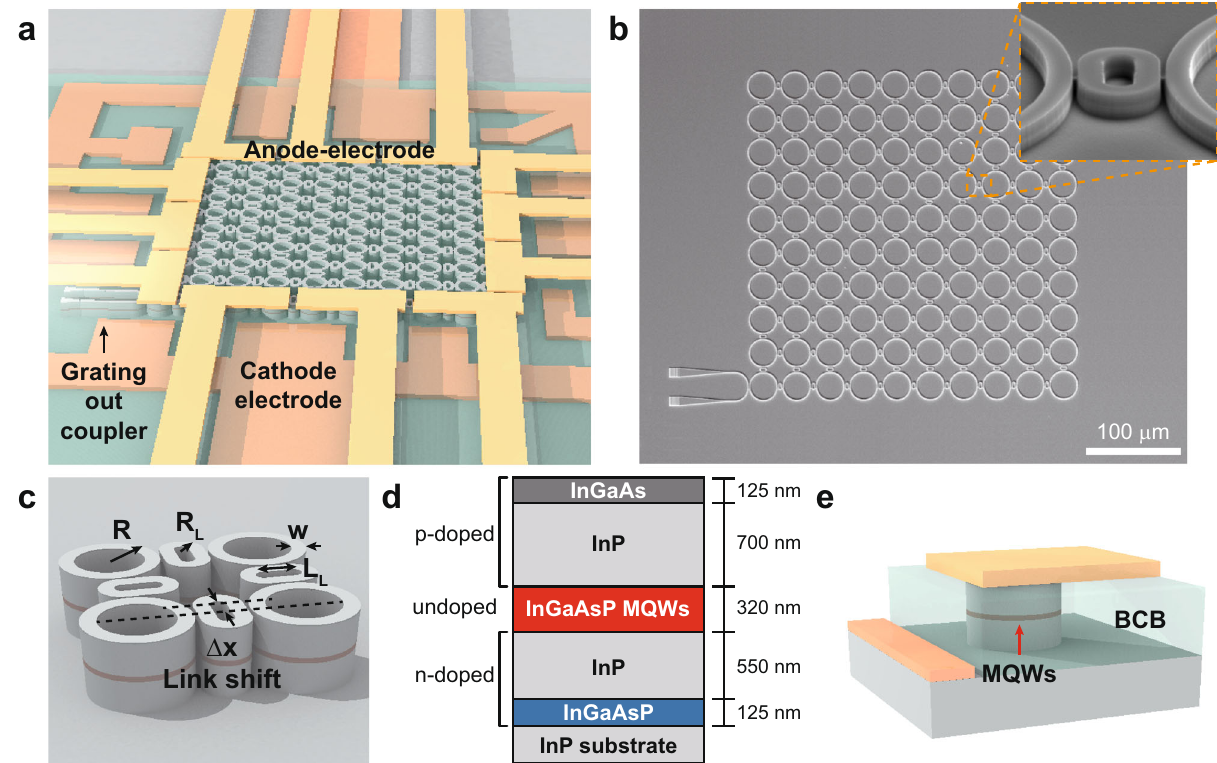
Fig. 1 Electrically pumped topological insulator laser structure. a A schematic illustration of an electrically pumped topological insulator laser lattice comprising of a 10 × 10 network of microring cavities that are coupled to each other through link resonators. b Scanning electron microscopy (SEM) image of a fabricated topological insulator laser array. The scale bar is 100 μ m. c A plaquette consisting of four site microrings and four links. d A schematic of the epitaxially grown InGaAsP/InP heterostructure wafer structure shows the location of the gain region in the resonators. e The position of anode and cathode electrodes with respect to the